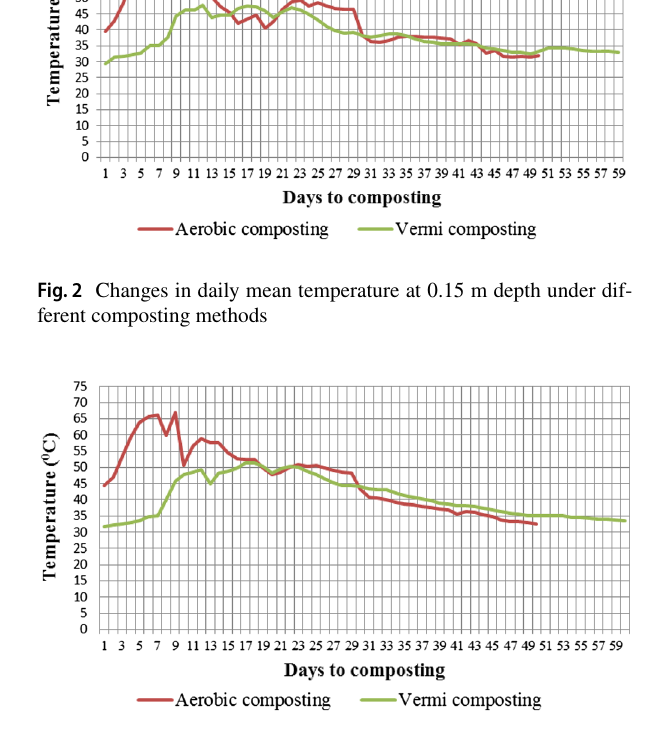
Fig. 3 Changes in daily mean temperature at 0.30 m depth under dif- ferent composting